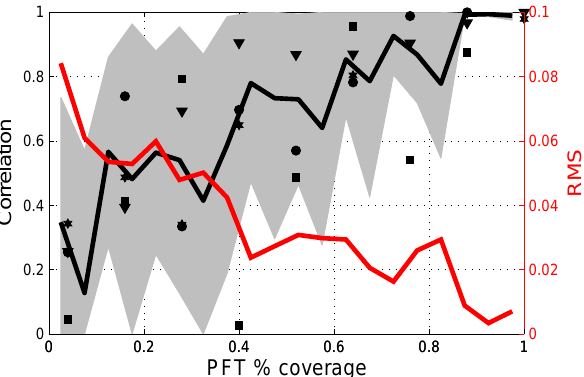
Fig. 6. Mean correlation (black line) between LAI time series obtained using ECOCLIMAP-I, GLOBCOVER and MODIS land covers, and its dependence in the PFT percentage in a given MSG/SEVIRI pixel for a 3 × 3 neighbourhood. The grey shaded area represents the dispersion of the correlation. PFT dependent cor- relation is superimposed (DBF: ◦ , ENF: (cid:3) , crops: O , grass: ∗ ). In addition, RMS resulting from the comparison of the time series is shown in red.